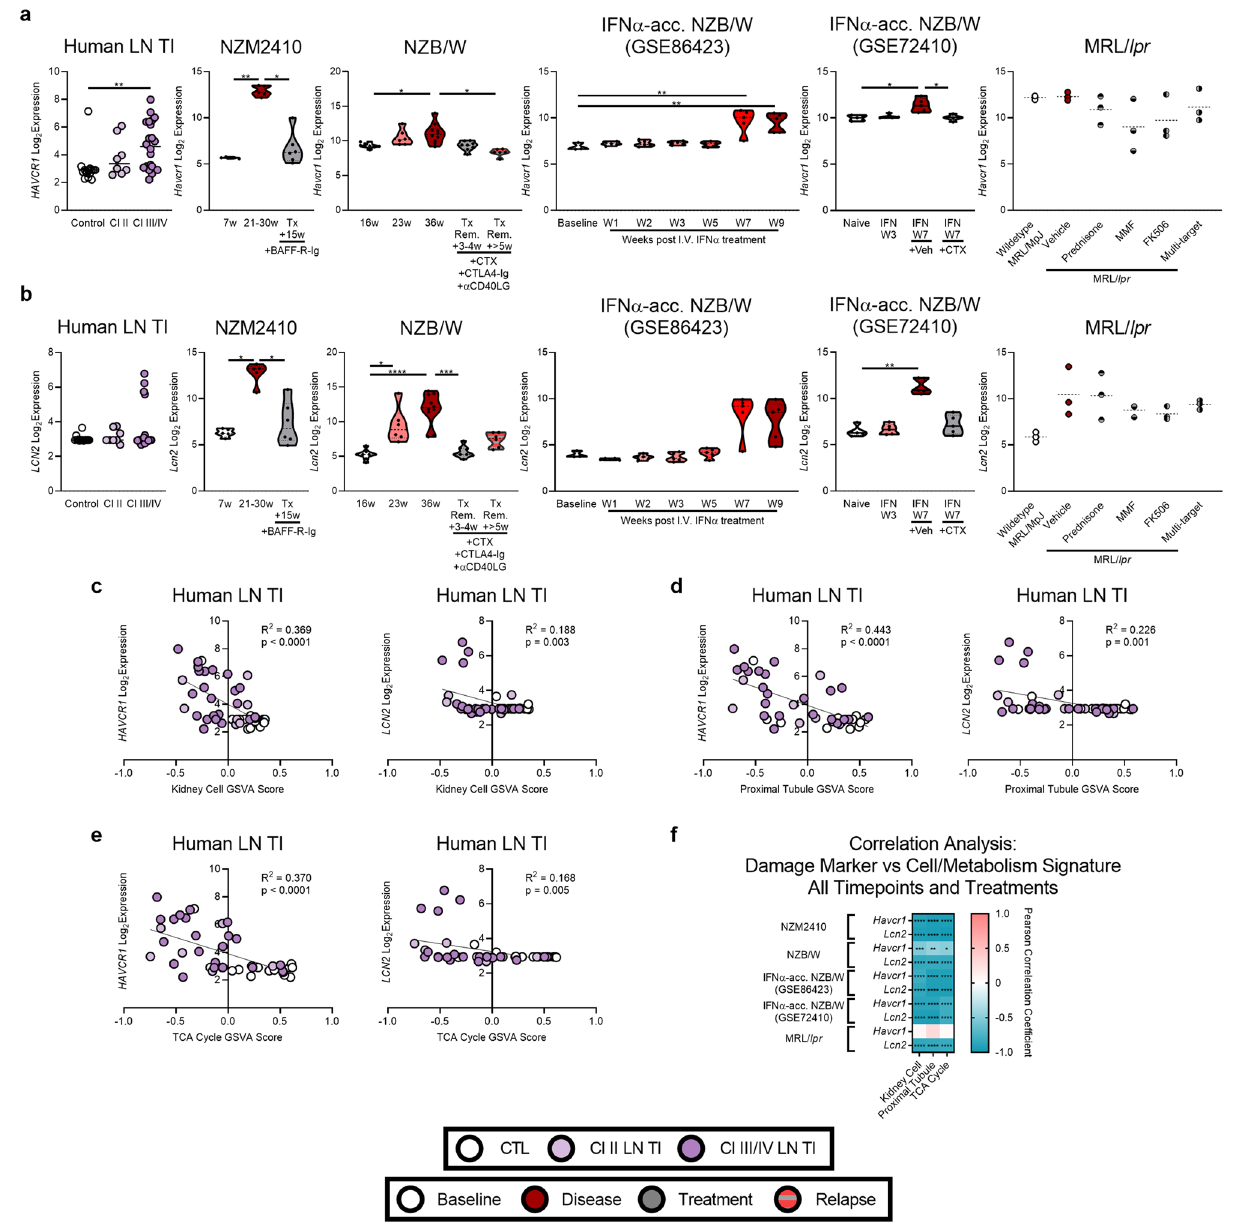
Figure 8. Cellular and metabolic gene expression changes correlate with expression of genes indicating tubular damage in human and murine LN. Log2 expression of ( a ) HAVCR1/Havcr1 and ( b ) LCN2/Lcn2 in human LN TI and the kidneys of (NZM2410 (GSE32583, GSE49898), NZB/W (GSE32583, GSE49898), IFNα-accelerated NZB/W (GSE86423), IFNα-accelerated NZB/W (GSE72410), and MRL/ lpr (GSE153021) mice. Each point represents an individual human or mouse. Significant differences in gene expression at each timepoint compared to disease were evaluated in the human TI with Welch’s t-test and in murine models with the Mann–Whitney U test. Linear regression between HAVCR1/Havcr1 and LCN2/Lcn2 expression and kidney cell, proximal tubule, and TCA cycle GSVA scores in all samples for ( c – e ) human and ( f ) murine LN. For all calculations